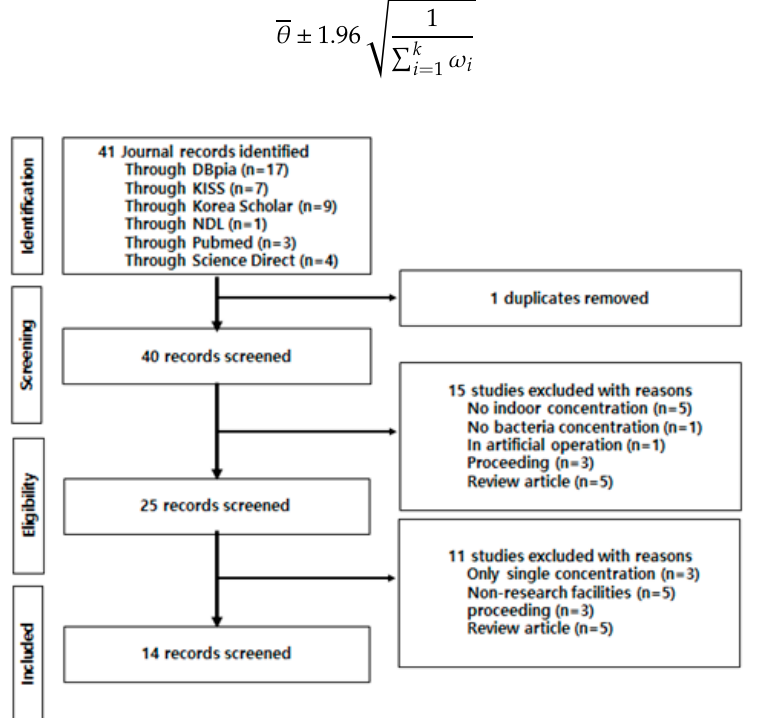
Figure 1. Mimetic diagram for qualitative meta-analysis using literature selection and survey.